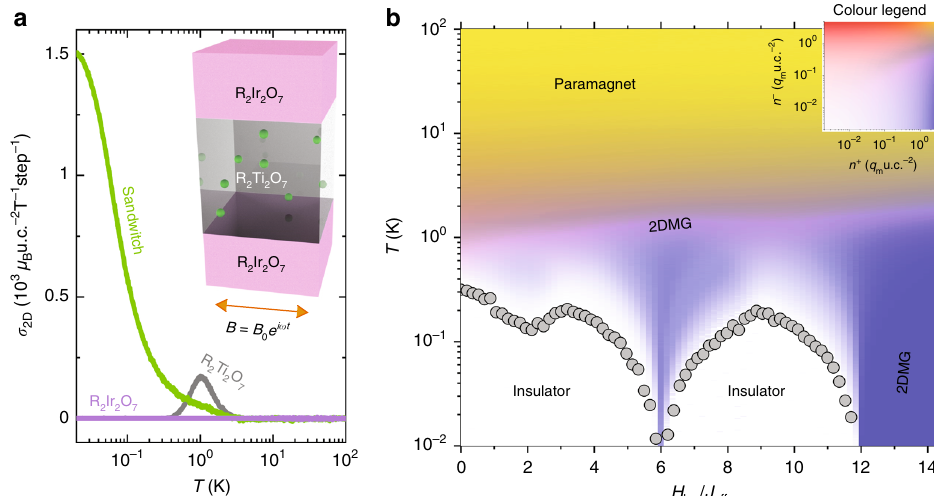
Fig. 3 Transport and thermodynamic properties of a R 2 Ir 2 O 7 /R 2 Ti 2 O 7 /R 2 Ir 2 O 7 (001) sandwich. a Idealized monopole A.C. sheet conductivity of the sandwich, whose unit is de fi ned as Bohr magneton per squared pyrochlore unit cell per Tesla per Monte Carlo step, taken at the frequency of 1/20 Monte Carlo steps as a function of temperature with H loc ∕ J eff = 14 showing a metallic transport behaviour as well as those for a pure iridate slab and a pure spin ice slab as references showing insulating transport behaviours. b The H loc ∕ J eff -T phase diagrams of the sandwich showing the monopole sheet magnetic charge density n + and the antimonopole sheet density n − . The above simulations are made with the nearest neighbor